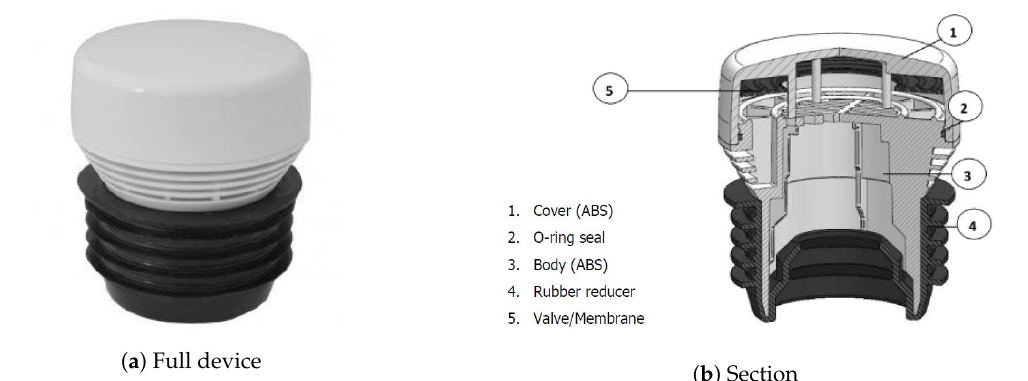
Figure 7. MiniHab HypAirBalance from Capricorn used in the Tupperwave small-scale model [37].